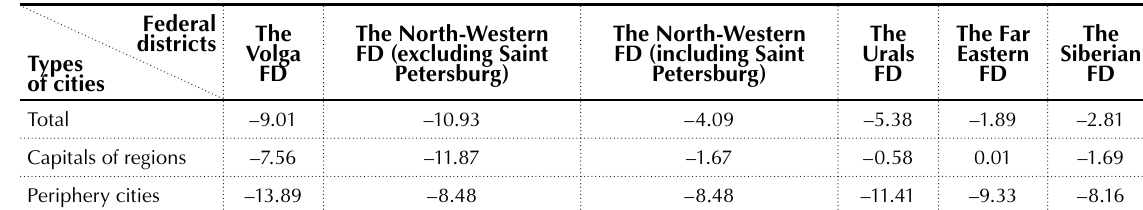
Source: calculated by the authors according to